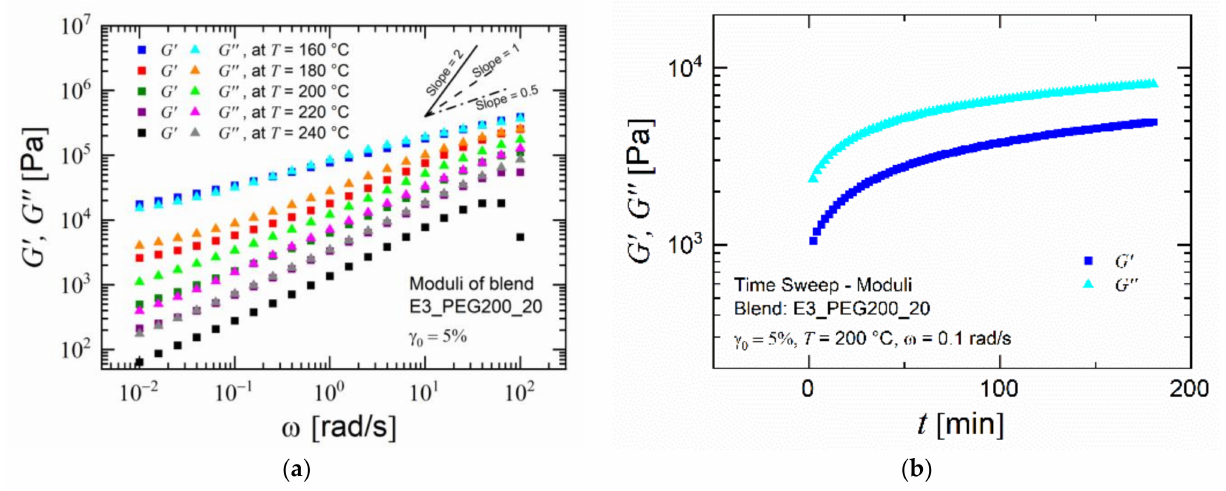
Figure 6. Rheological results for blend E3_PEG200_20: ( a ) frequency sweep: magnitude of moduli versus angular frequency at various temperatures; ( b ) time sweep: magnitude of moduli versus time at 200 ◦